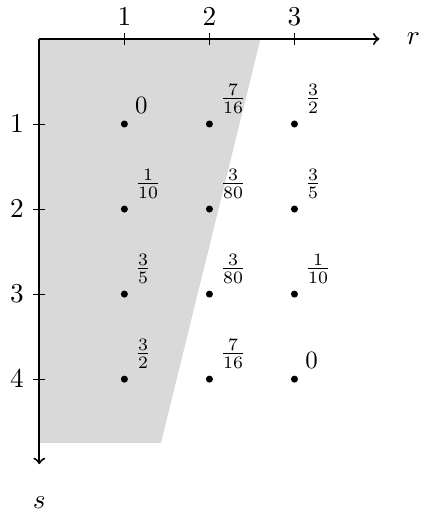
Figure 1 . Kac table of the tri-critical Ising minimal